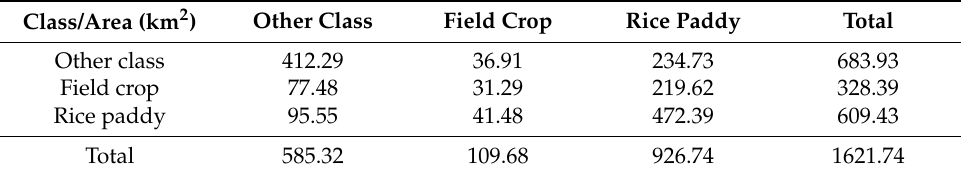
Table 10. Confusion matrix of the OLWDTW method in test site 1.